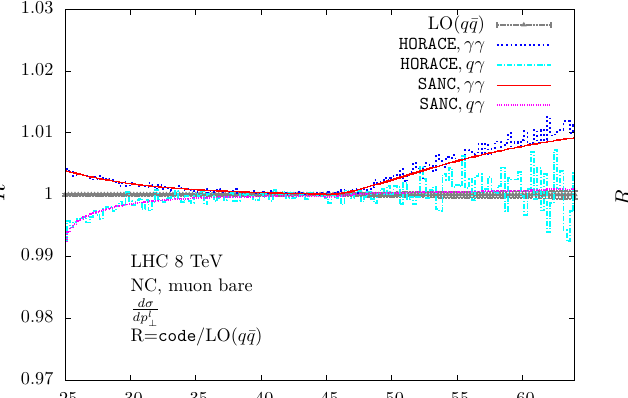
verse momentum ( left plot ) and the lepton-pair invariant mass ( right plot ) and are obtained with HORACE and SANC . Separately shown are the contributions of the LO γγ → μ + μ − subprocess and the O (α) ( − ) ( − ) γ q → μ + μ − q